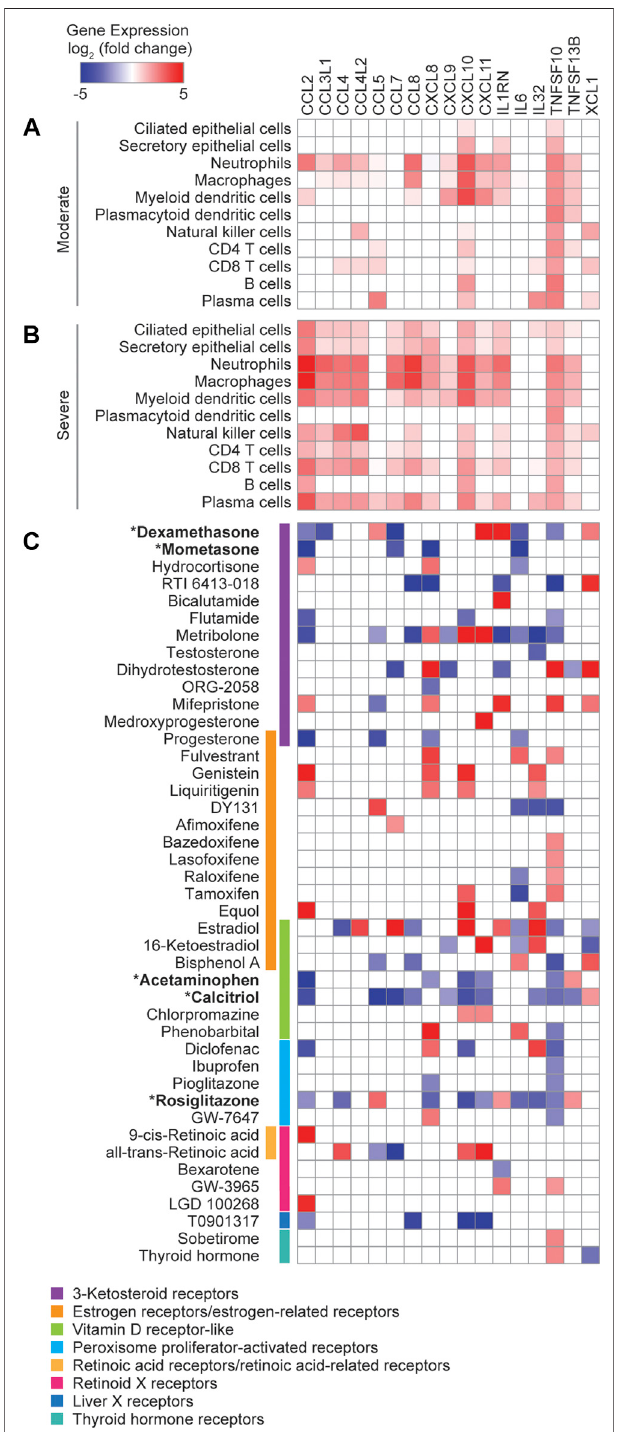
FIGURE 3 | Exploration of repurposable nuclear receptor drugs. (A,B) Heatmapsshowingtheaveragelog 2 (foldchange)cytokinegeneexpressionin theindicatedcelltypes fromBALFsof (A) moderateand (B) severeCOVID-19 patients relative to healthy controls. (C) Heatmap showing the average log 2 (fold change) cytokine gene expression in response to treatment with small molecule NR drugs. Data was obtained from the Signaling Pathways Project Transcriptomine resource.